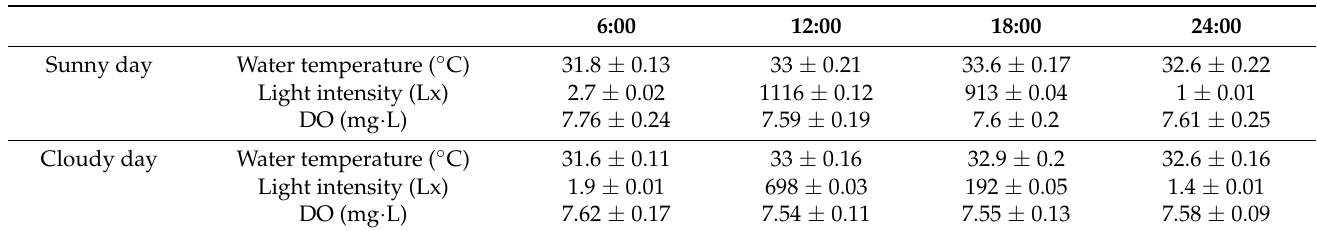
Table 1. Environmental indicators.